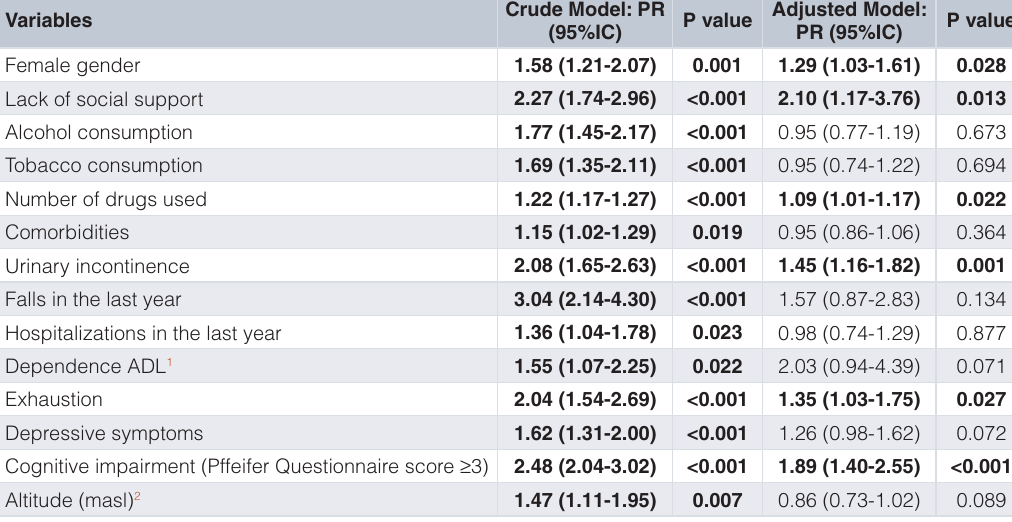
Table 3. Poisson regression to determine factors associated with poor physical performance.